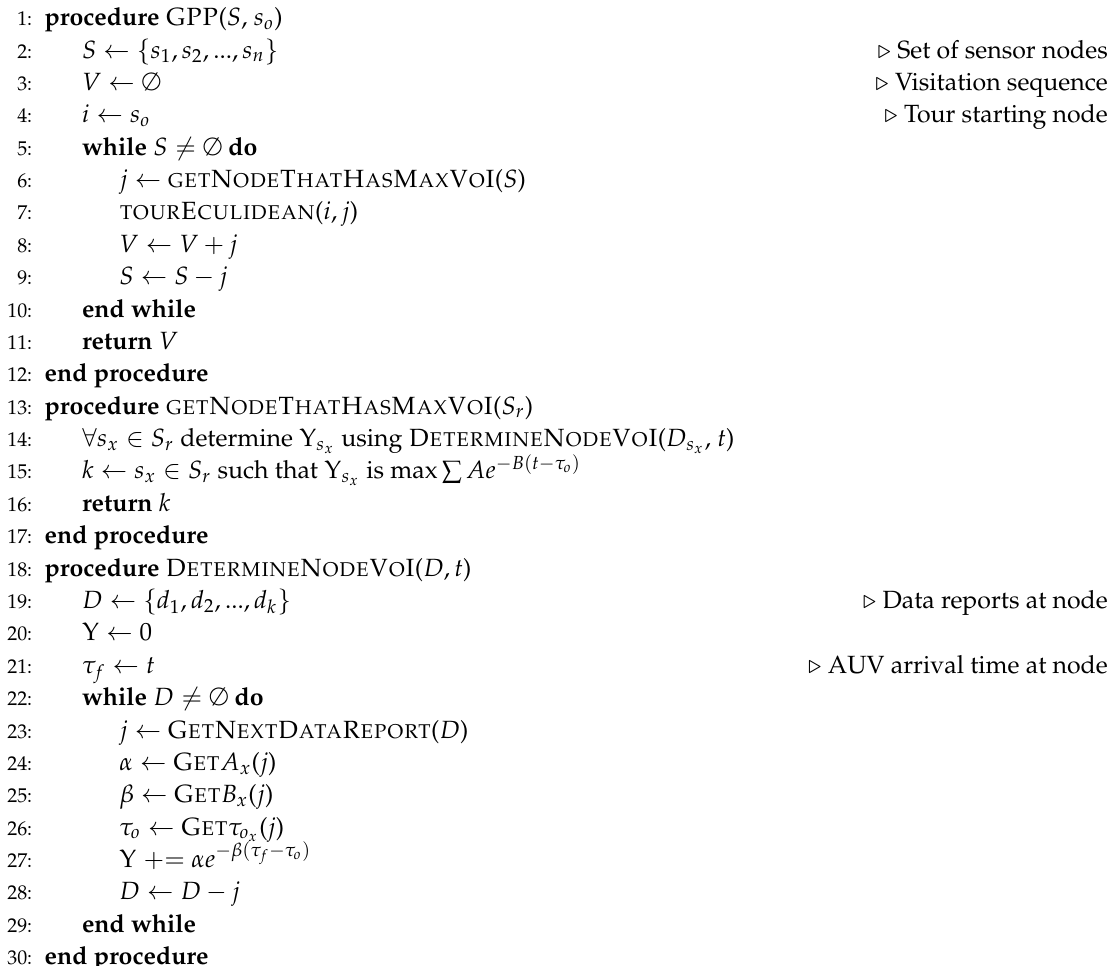
Algorithm 2 Greedy Path Planner– GPP